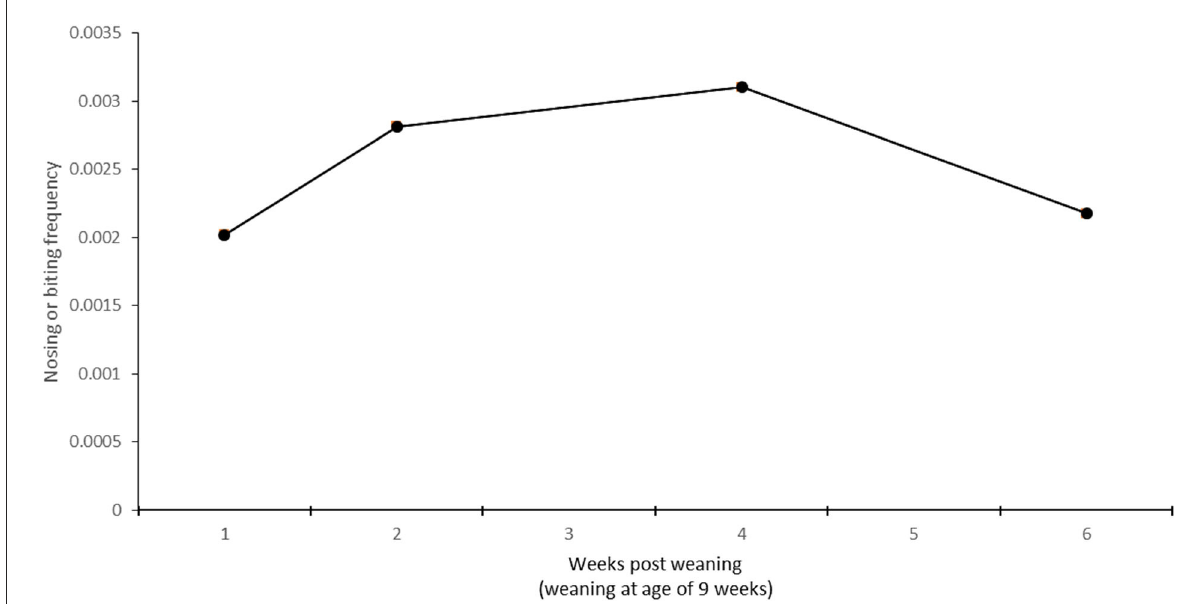
FIGURE4 Frequency of nosing or biting behavior (directed to the trunk, belly, or other body parts) after weaning (weaning at 9 weeks of age) in one group of 69 pigs. Descriptive data based on weekly averages of 4h instantaneous sampling (5-min interval), with observations during the daytime. Behaviors were observed twice during weeks 9 and 10 and once during weeks 12 and 14. Observed nosing events were divided by the number of animals visible in one of the three areas the pigs used for resting.